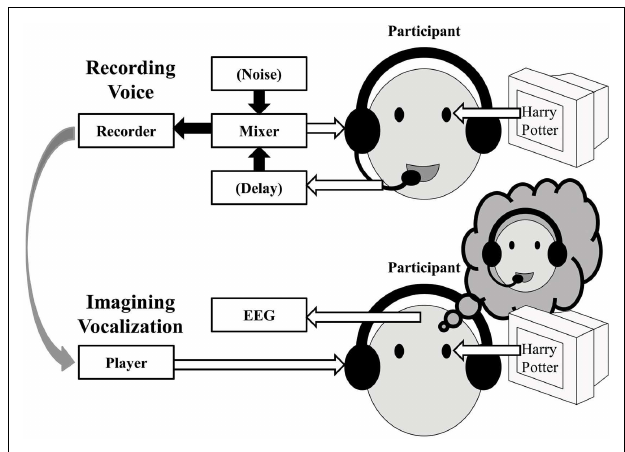
FIGURE 4 | Schematic of the procedure for Experiment